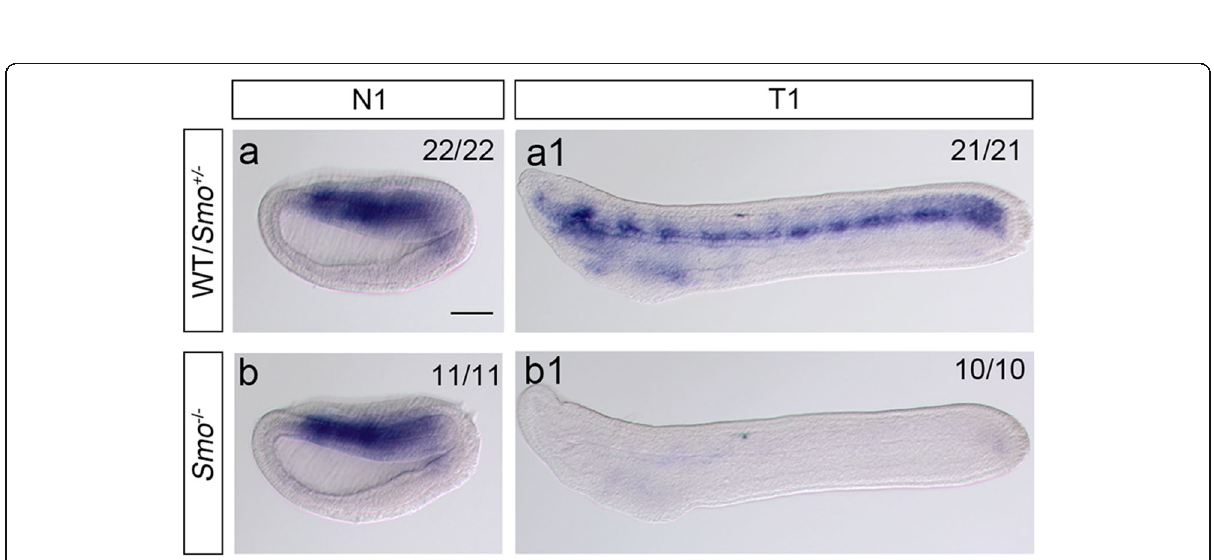
Fig. 4 Ptch expression in Smo mutant embryos. Ptch expression was visualized by in situ hybridization, and all embryos were placed anterior to the left; a, b: Ptch expression in WT or Smo +/ − embryos; a1, b1: Ptch expression in Smo − / − embryos. Smo gene knockout has no effect on Ptch expression at the N1 stage but results in diminished Ptch expression at the T1 stage. N1, early neurula stage; T1, tail bud stage before mouth opening; scale bar, 100 μ